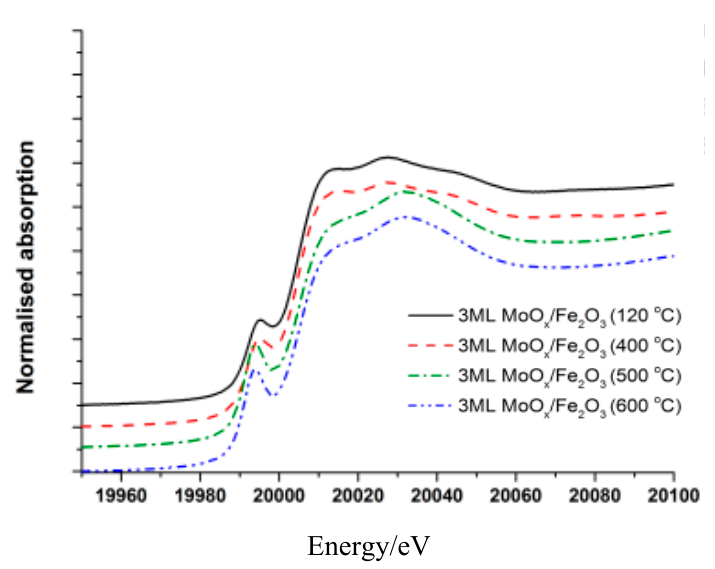
Figure 7. XANES spectra of 3ML MoO x /Fe 2 O 3 catalysts annealed to different temperatures. Image adapted from C. Brookes et al., ACS Catal. , 2014, 4 (1), pp. 243–250 [16].